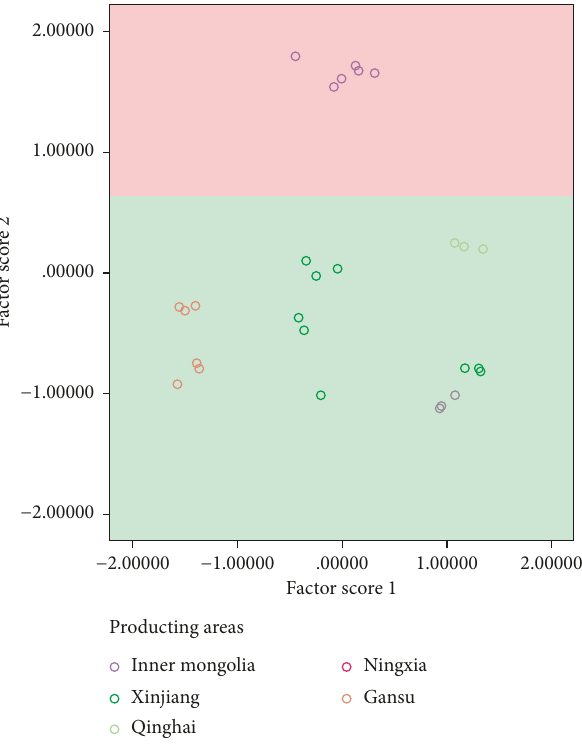
Figure 5: The score plot of PCA of C. songaricum